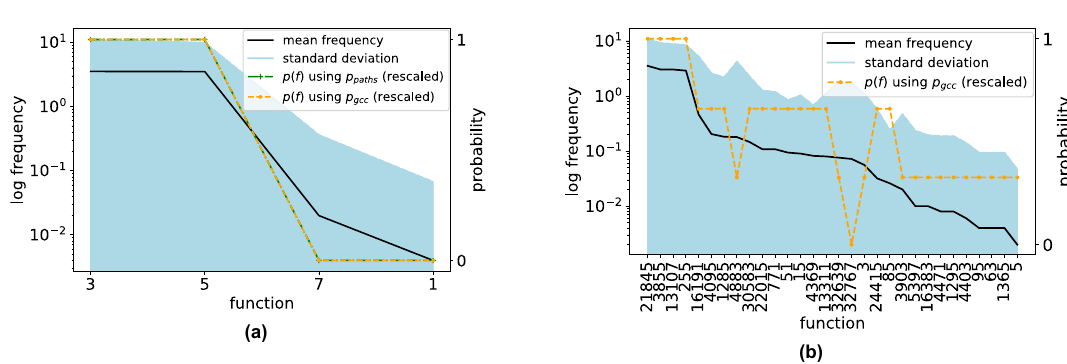
Figure 3. Function frequency corresponds to probability of required paths in a rank-ordering. ( a ) Logarithmic frequency of non-zero functions computed by the ensemble of LTM cascades for N = 10000 nodes, average degree z = 4 and k = 2 inputs, over 500 realizations reveals an apparent rank-ordering (solid line). Mean frequency is proportional to path probabilities, having a Pearson correlation of 1.0, both predicted by C ( f ) + 1 probabilities derived from logic motifs using p path (‘+’) [e.g. see Eq. (1)], and complexity p gcc (large dot) Eq. (4) (rescaled, overlaid, both dashed). Thus Eq. (4) also well-predicts Eq. (1). Frequency therefore varies inversely with decision tree complexity C (‘+’). ( b ) Rank-ordering is more evident for k = 4 inputs, appearing 2 = 0.88 as a decreasing exponential with goodness of fit r . Here, Pearson correlation between p ( f ) and mean frequency is 0.74. Shaded regions are one standard deviation. Probabilities have been centered and